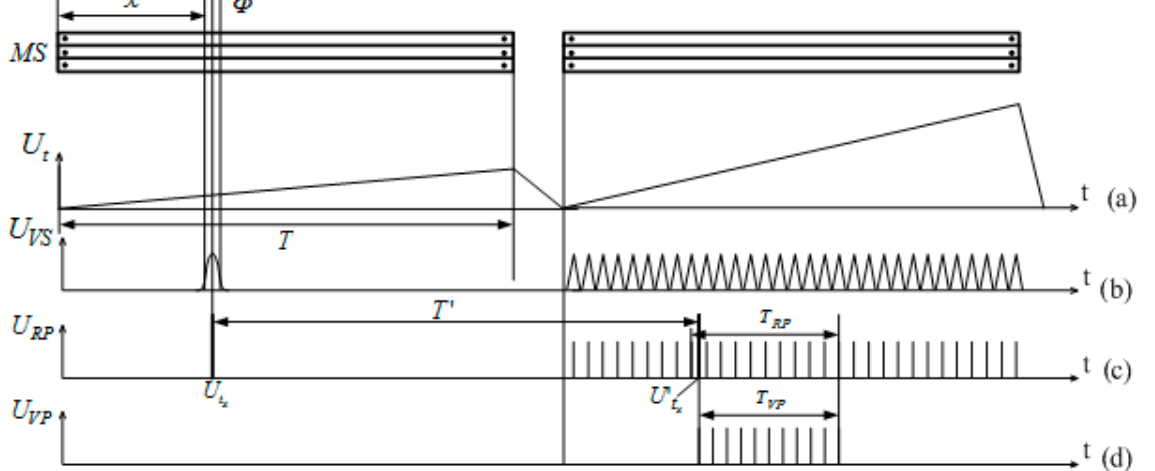
Figure 6. Timing diagrams of the device for measuring the coordinates of objects: ( a ) Dependence of variables U t - t ; ( b ) dependence of variables U VS - t ; ( c ) dependence of variables U RP - t ; ( d ) dependence of variables U VP - t .